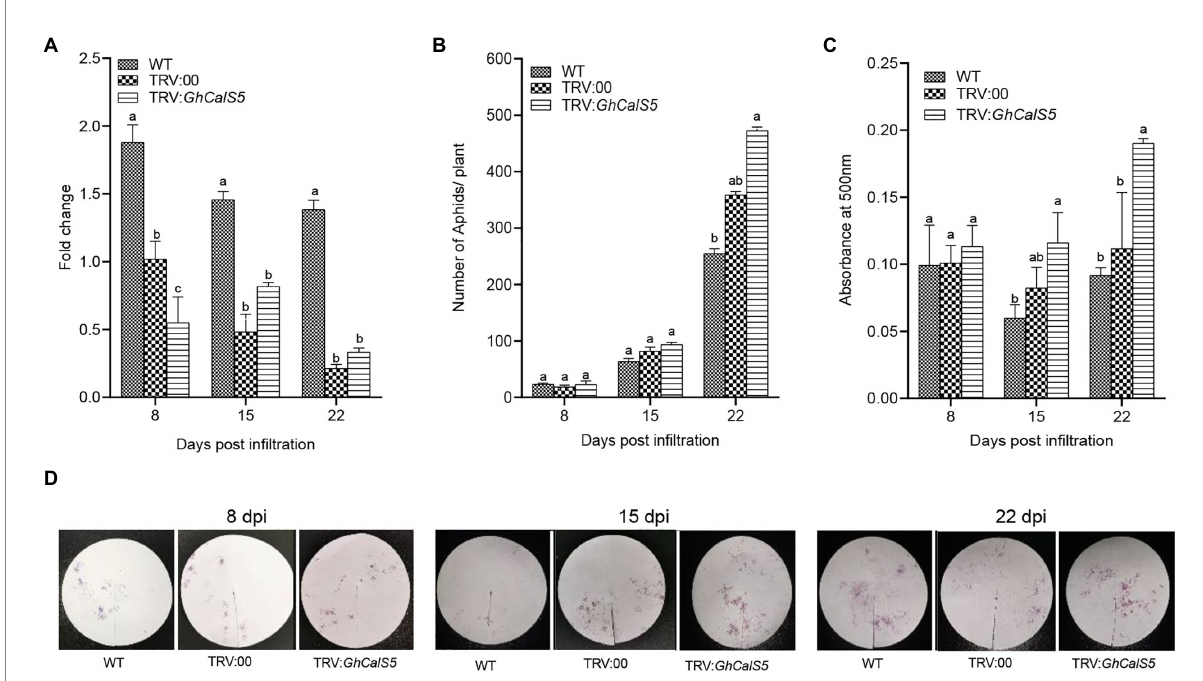
FIGURE 4 Silencing expression of GhCalS5 increased aphid population and feeding in cotton plants. (A) fold change in transcription of GhCalS5 in cotton leaves, (B) aphid no-choice assay, (C) absorbance levels of aphid honeydew at 500 nm (D) aphid honeydew deposition staining by ninhydrin. DPI, days post infiltration. Number of plants used = 3 per treatment. One-way ANOVA analyzed data. Error bars represents the SD of three biological replicates. Different letters indicate significant differences ( p < 0.05) based on Tukey’s HSD